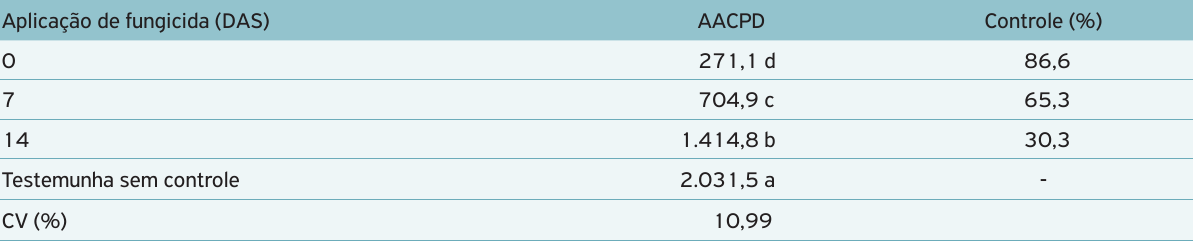
Tabela 2. Área abaixo da curva de progresso de doença e porcentagem de controle em relação à testemunha sem controle, em função de diferentes momentos de aplicação de fungicida para o controle da ferrugem da folha do trigo, em Londrina (PR), 2010.